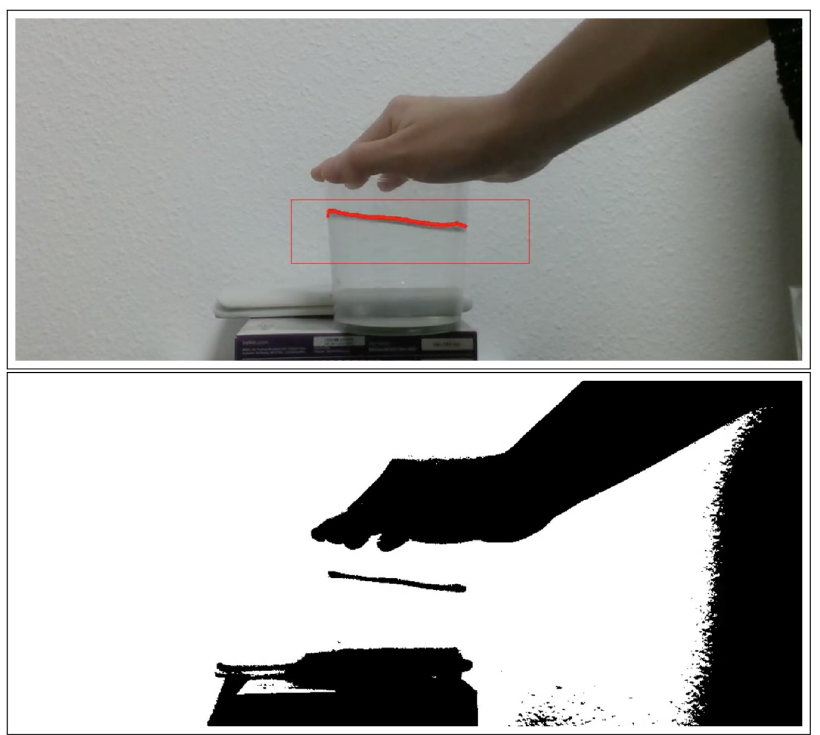
Fig 3. Example of frame binarization. Original frame (top) versus binarized one (bottom). The picture is transformed firstly to gray scale for gentle binarization. Noise is also filtered to detect a smooth surface, which is highlighted in red in the top figure.